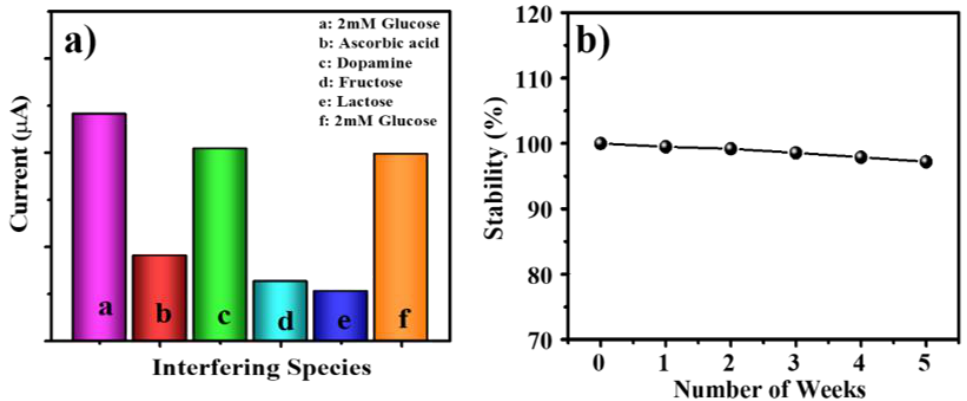
11 of 15 Figure 6. Calibration curve for glucose concentration determination using the Glucose liquid color kit ( a ) 0.1 – 12 mM ( b ) 0.1 – 1 mM ( c ) 3 – 12 mM for different glucose concentration. 3.6. Selectivity and Stability of the Sensor The proposed biosensor was examined for interfering species in blood serum, includ-